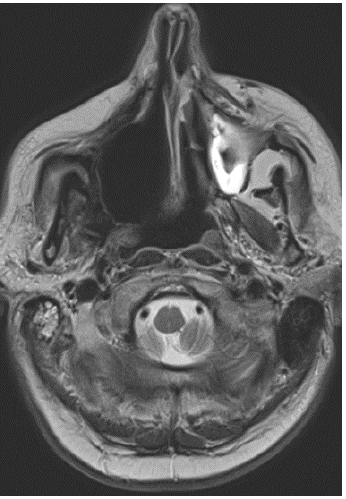
Figure 6. Follow-up MR imaging demonstrates a postresection cavity without tumour residue or recurrence in the right maxilla (5 years after surgical treatment). Axial imaging in T2 weighting.